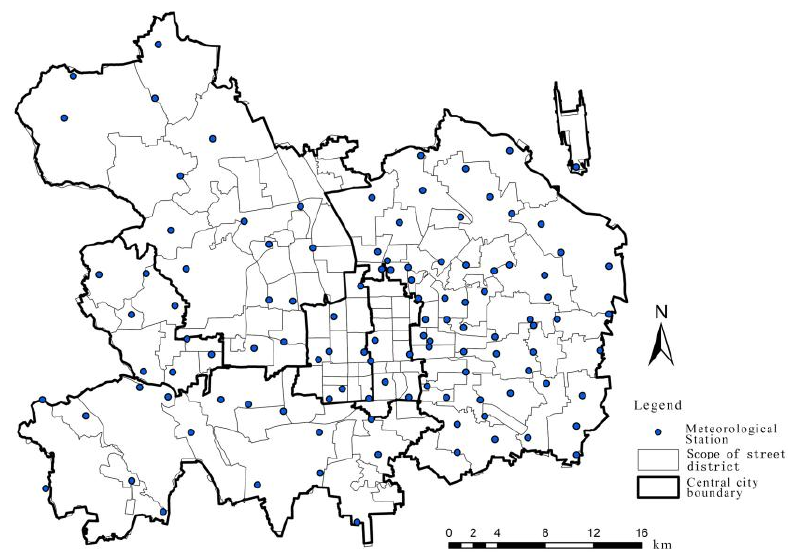
Figure 2. Distribution of street districts and weather stations in the central urban area of Beijing.